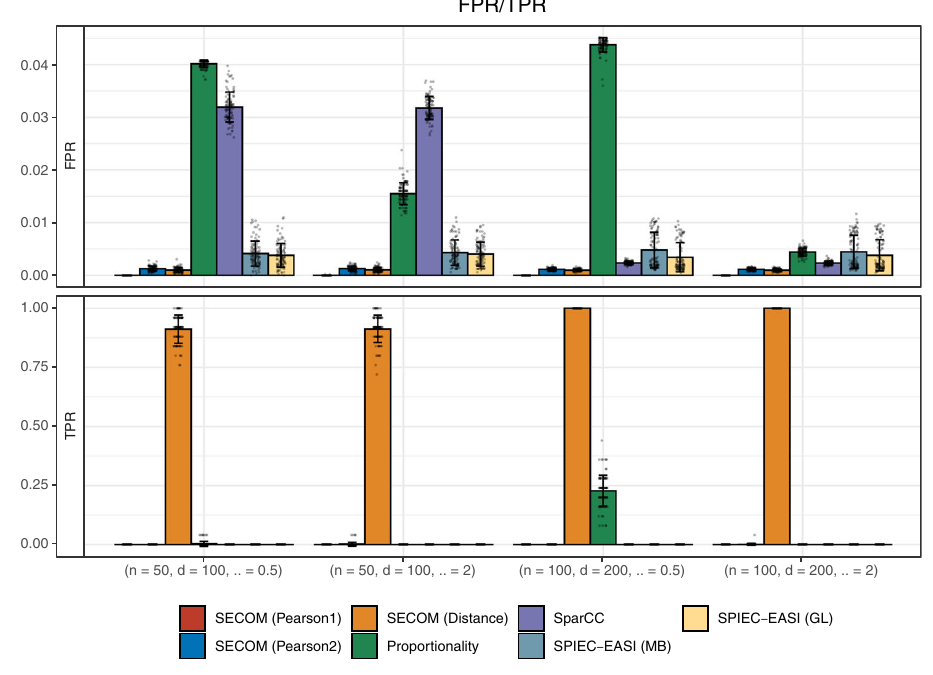
Fig. 3 | Comparisons of false/true positive rate (FPR/TPR) for identifying non- linearrelationshipswithinanecosystem. Syntheticdataweregeneratedfromlog- normal distributions. The X-axis denotes the simulation settings, which are a com- binationofsamplesize n ,numberoftaxa d ,andthedispersionparameter α .Results are represented by the average of corresponding measure (FPR/TPR)±standard